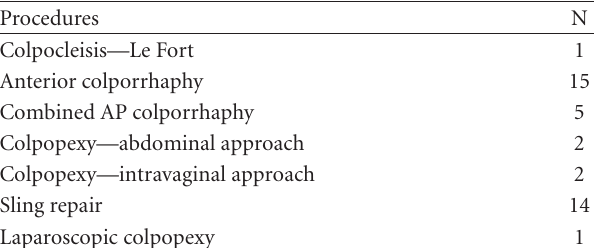
Table 2: Procedures performed for correction of prolapse and urinary